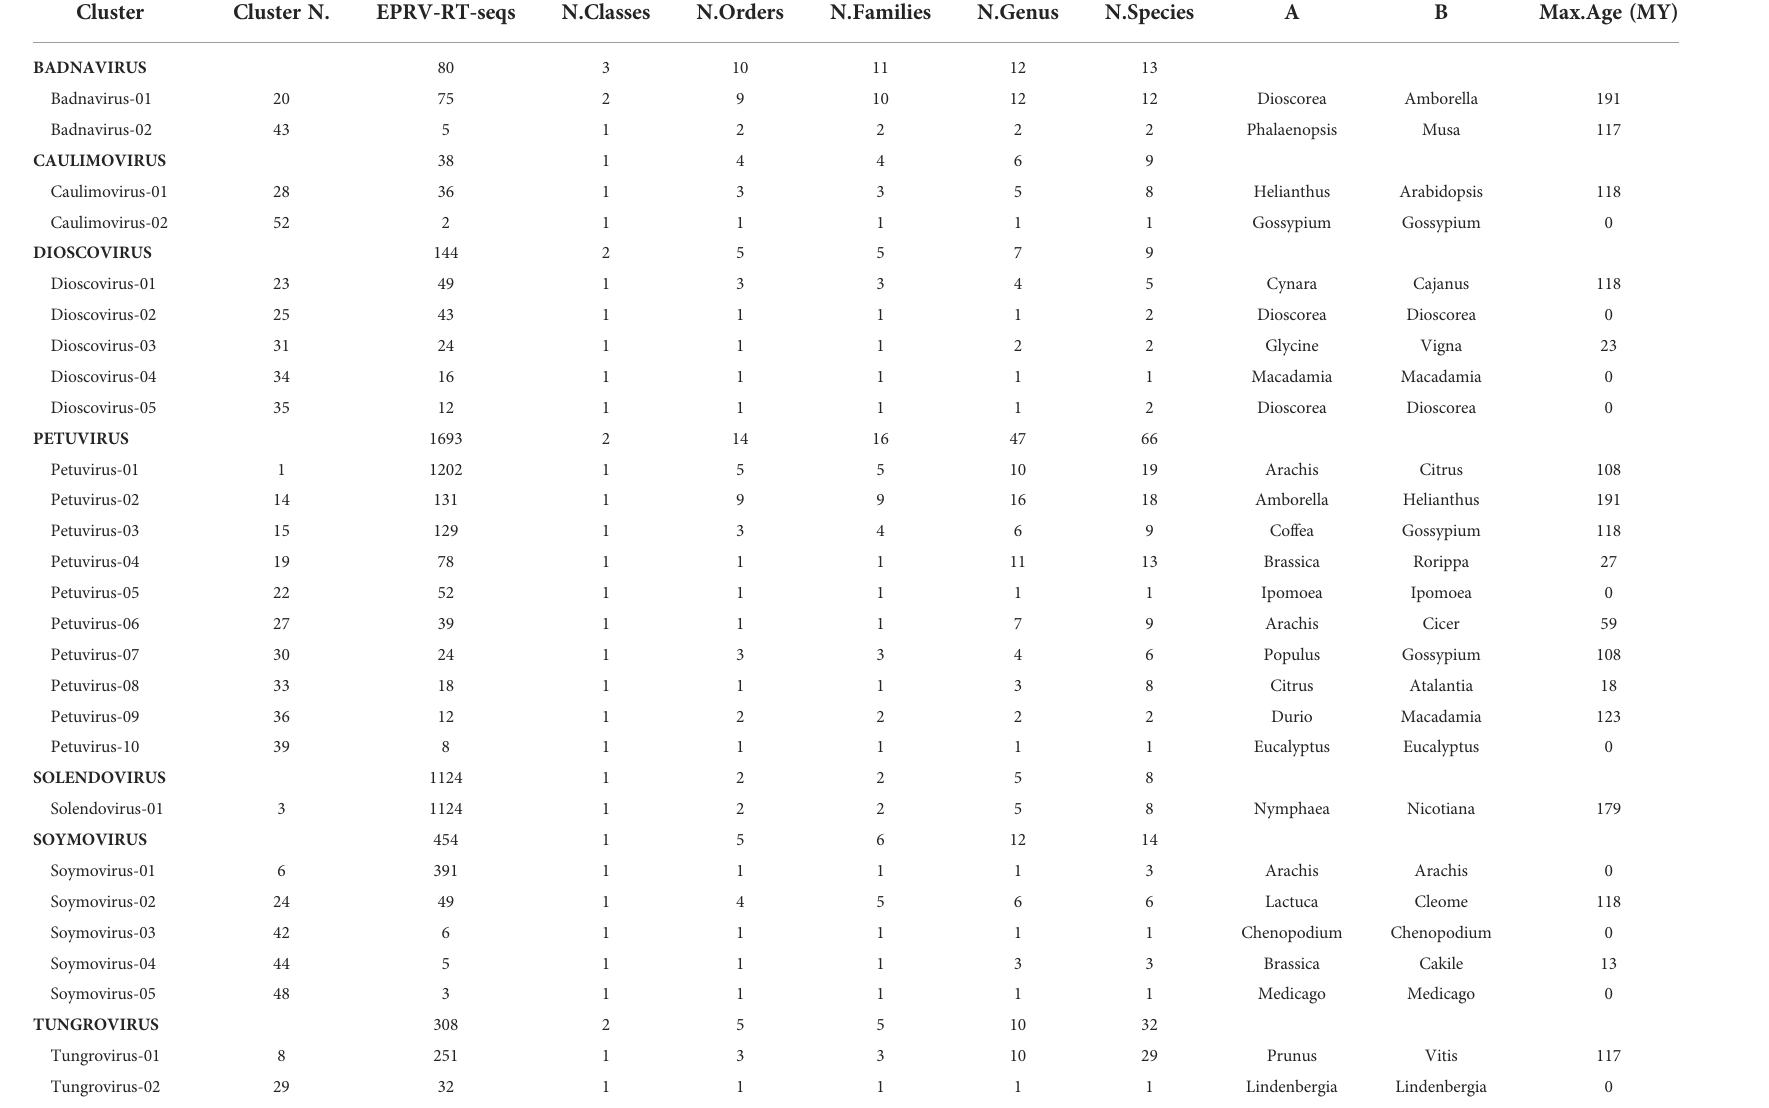
TABLE 1 Cluster60